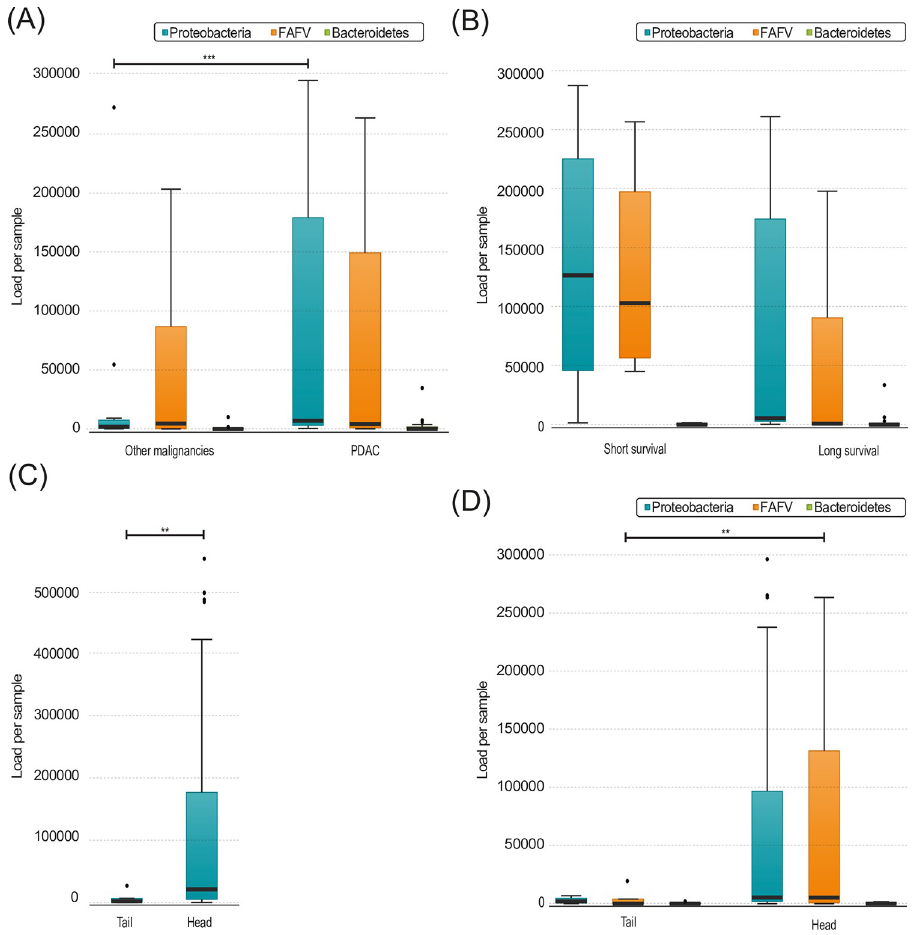
patients with short (n = 4) and long survival (n = 15) (FAFV p = 0.062) (C) Total load in pancreatic biopsies, divided by head (n = 44) and tail (n = 7) biopsies (p = p = 0.004) (D) Load per phylum in pancreatic biopsies, divided by head (n = 44) and tail (n = 7) biopsies (FAFV p = 0.004, Proteobacteria p = 0.073). Boxplots: Black bar denotes median, box denotes the interquartile range, whiskers indicate the range of values that are outside of the interquartile